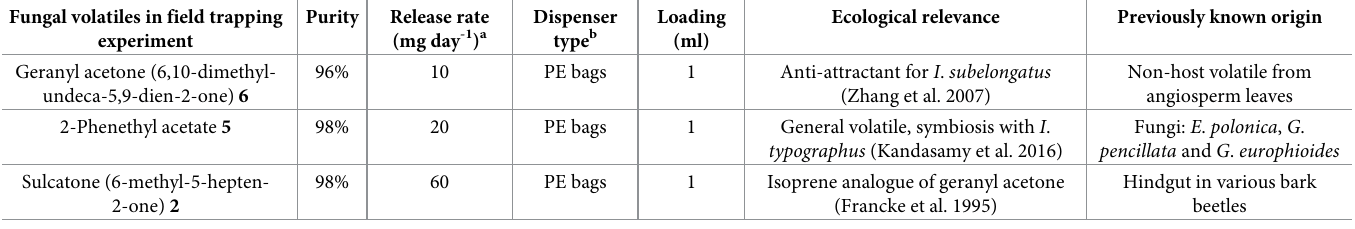
Table 2. Chemicals, release rates and dispensers used in field trapping